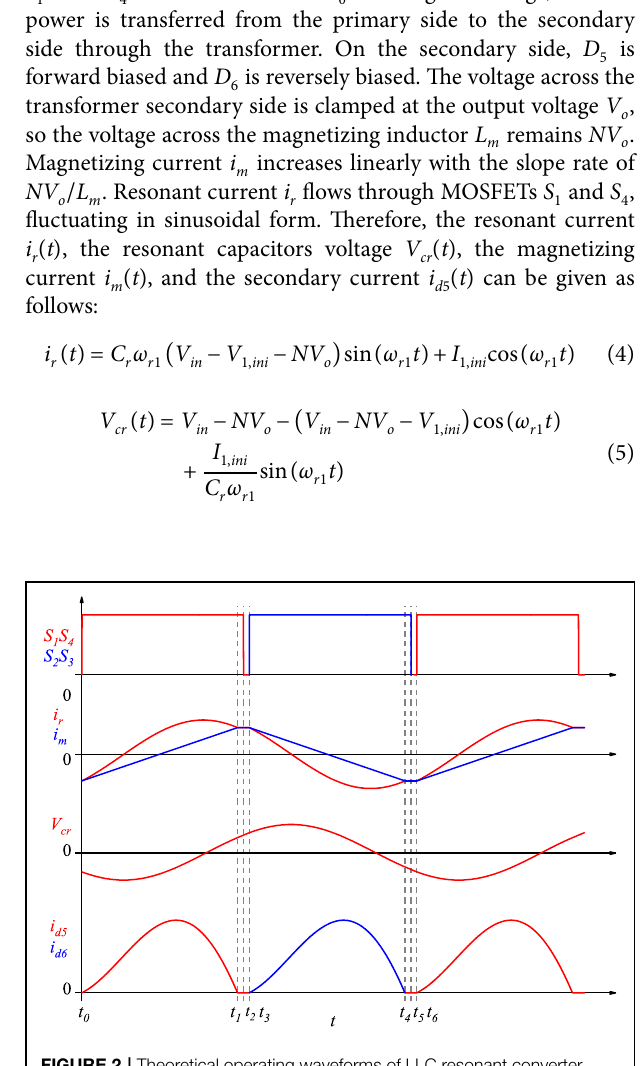
FIGURE 2 | Theoretical operating waveforms of LLC resonant converter under PFM